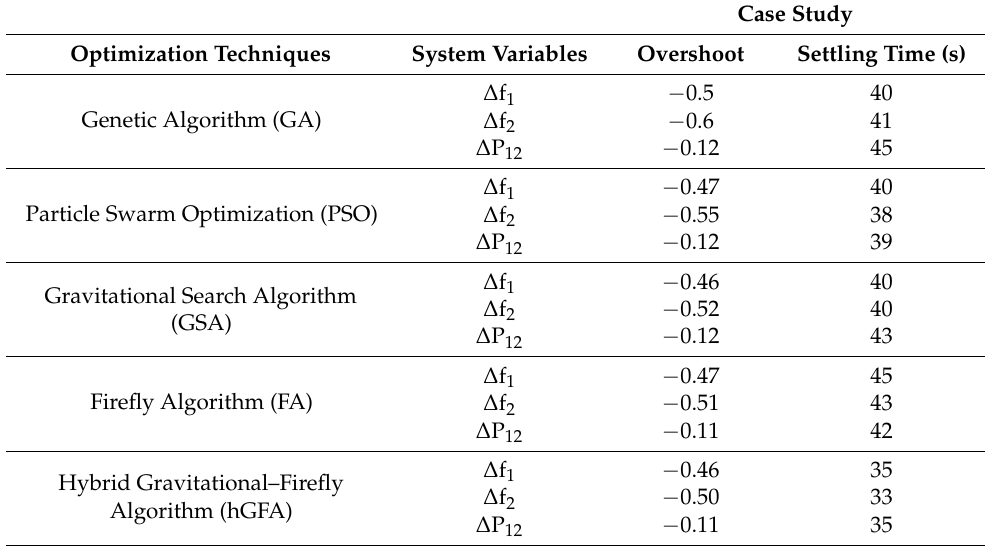
Table 3. Comparison of optimization techniques based on overshoot and settling time for case study-I.